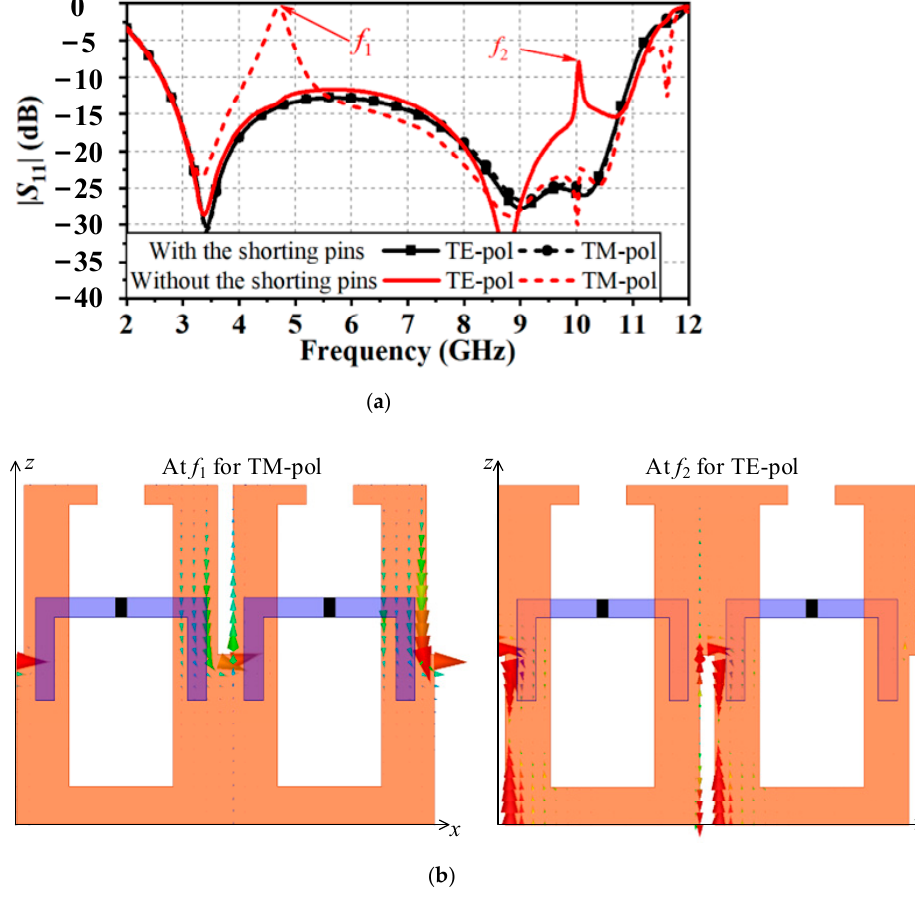
Figure 7. ( a ) Simulated | S 11 | of the proposed dual-polarized 3D absorber with/without the shorting pins; and ( b ) current distribution at the reflection frequencies. pins; and ( b ) current distribution at the reflection